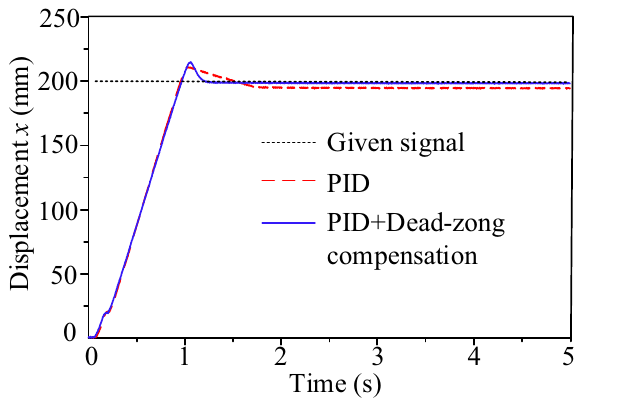
Figure 19. Displacement response